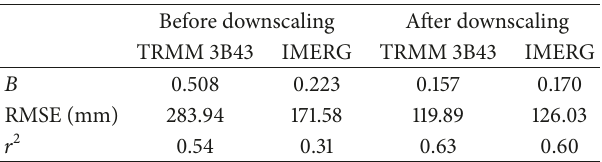
Table 4: Statistical results for comparisons of TRMM 3B43 and IMERG with observed precipitation before and after downscaling for